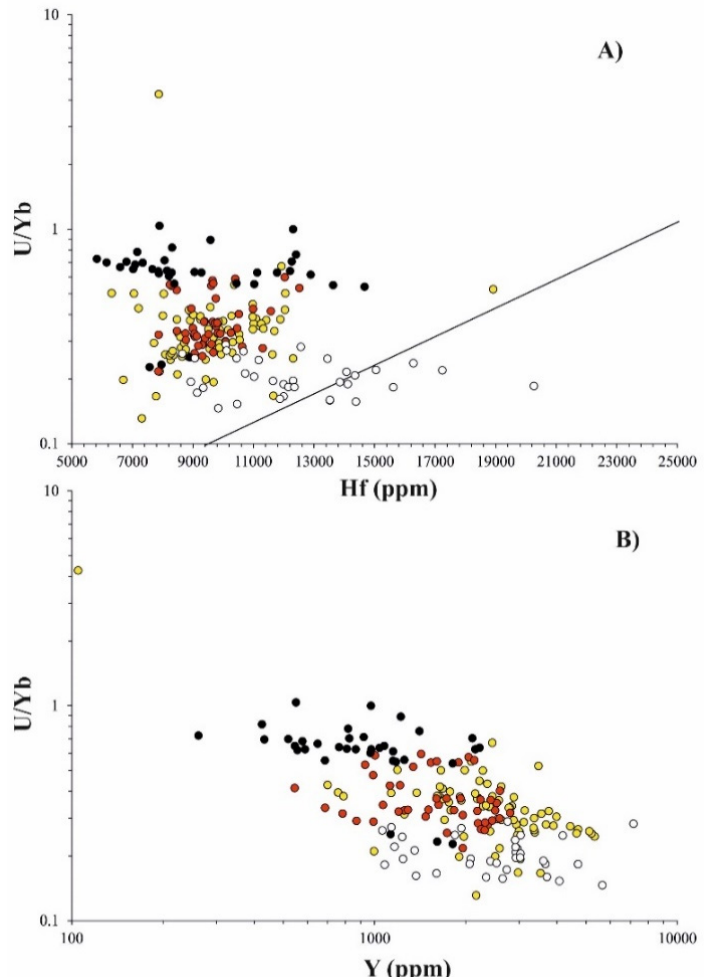
Figure 7. Range of REE content in the studied samples.